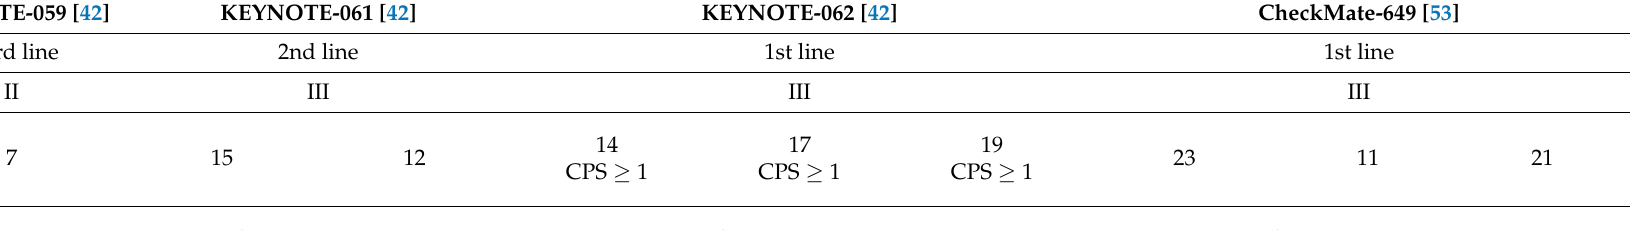
Table 3. Clinical trials for MSI-H/dMMR metastatic gastric cancer/gastroesophageal junction